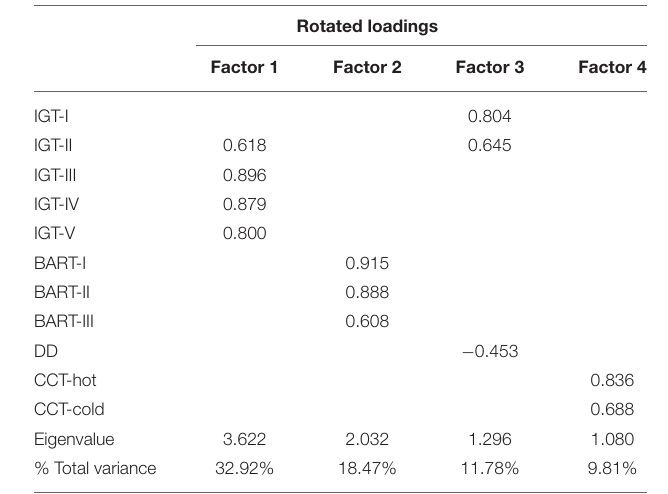
TABLE 3 | Exploratory factor analysis: Table for the decision-making tasks.